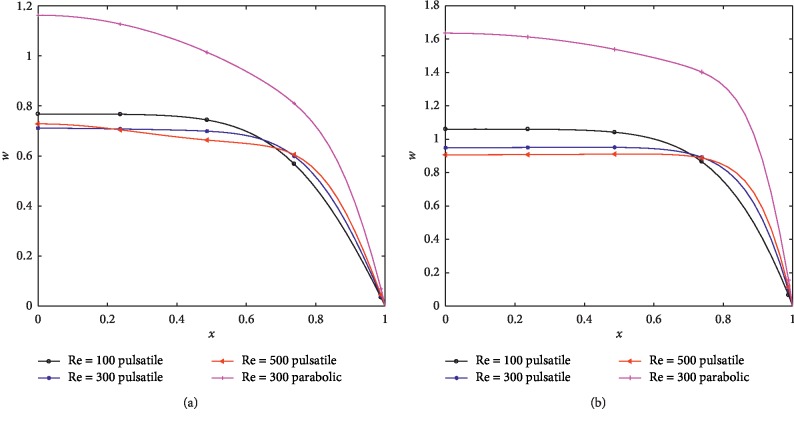
Axial velocity profiles for different Re at (δ1=0.2, δ2=0.4) (a) z=10. (b) z=19.